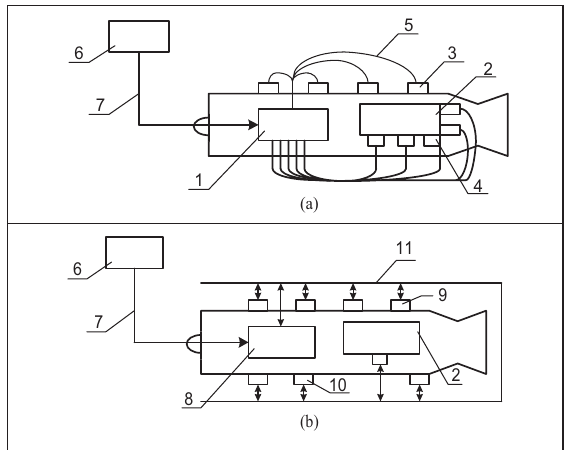
Figure 1. Structural construction of ACS gas turbine en- gine with centralized (a) and distributed (b)